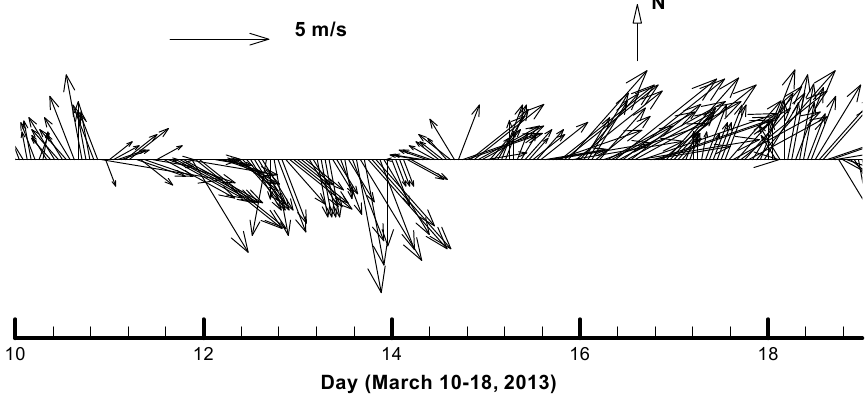
Figure 3. Wind speeds and directions near Enid Lake.